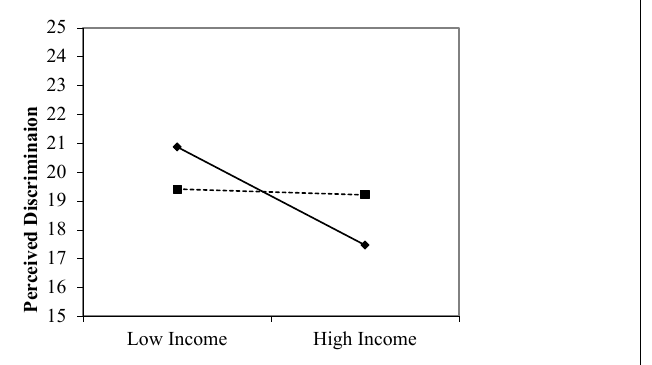
Figure A1. Interaction between race and income on perceived discrimination in White (solid line) and African American (dotted line) men. Source: National Survey of American Life. Table A2. Summary of linear regression on the effects of educational attainment and household income on perceived discrimination in the pooled sample of African American and Non-Hispanic White men in the National Survey of Amer- ican Life.